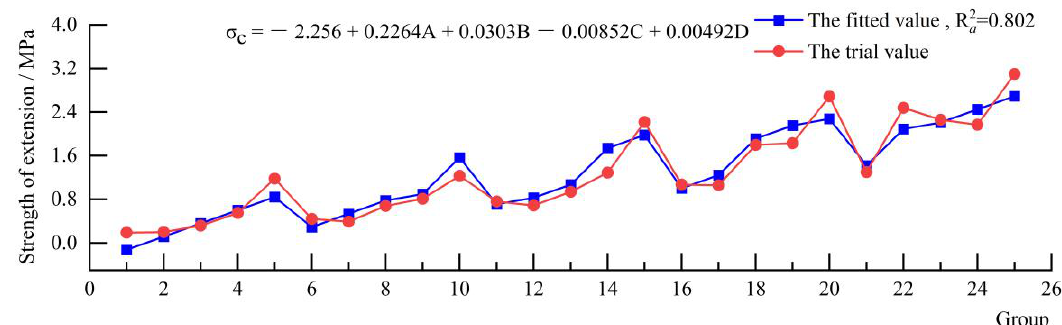
Figure 6. Comparison of fitted and experimental results for compressive strength.